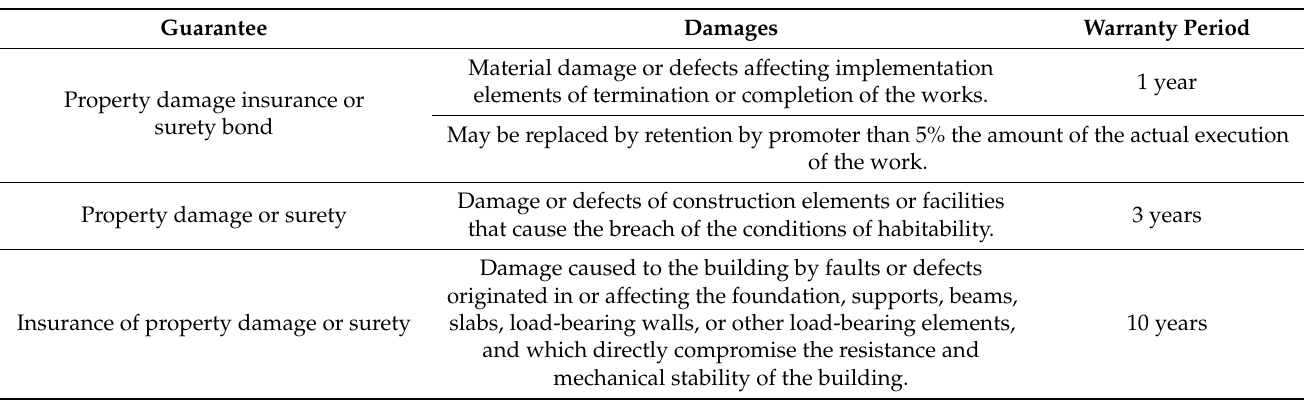
Table 6. Guarantees scheme of reference provided by the LOE per type of material damages. Source: LOE. Translated by the